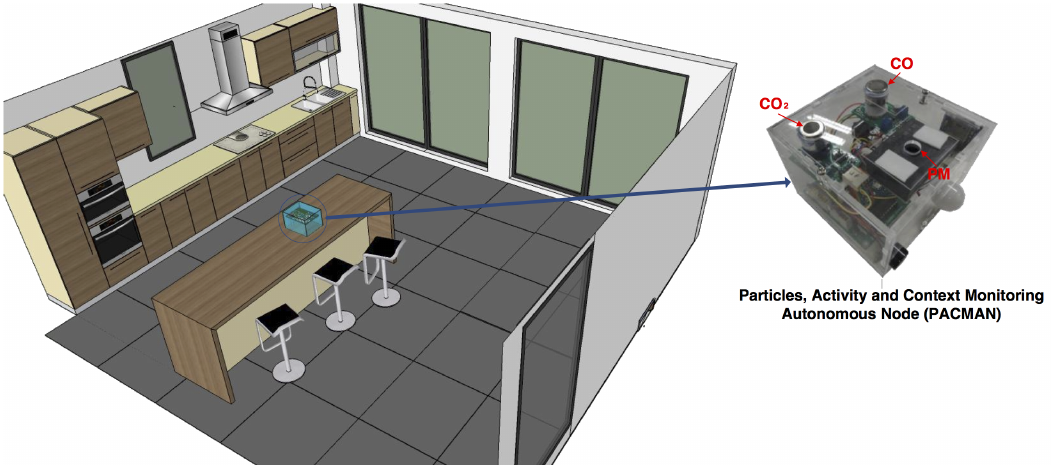
Figure 1. The experimental environment.